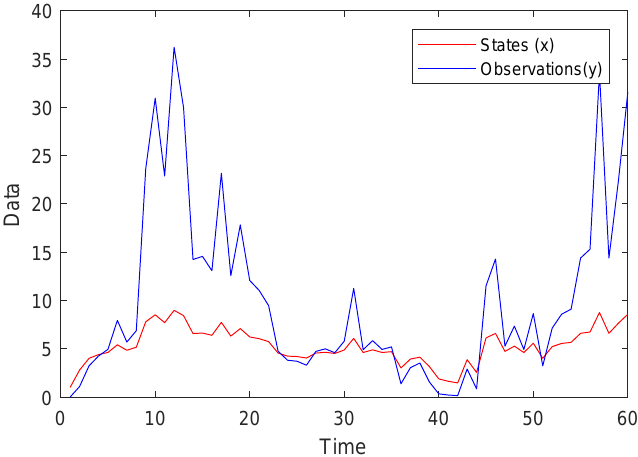
Figure 5. System data generated in a single Monte Carlo run.